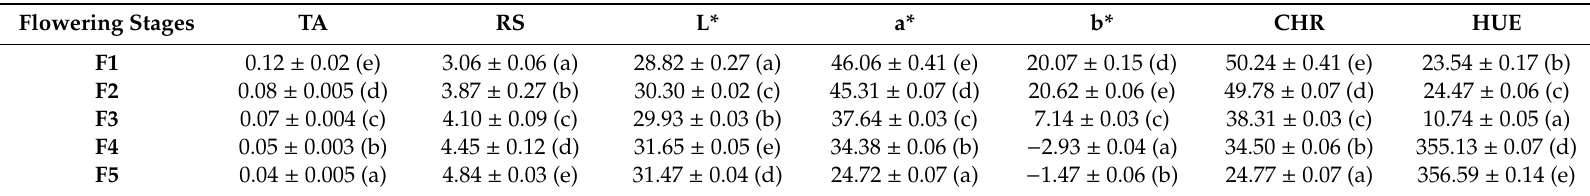
Table 1. Physicochemical parameters of feijoa petals at di ff erent flowering stages (TA: Titratable acidity; RS: Reducing sugars; L*: Lightness; CHR: Chroma; HUE: Hue